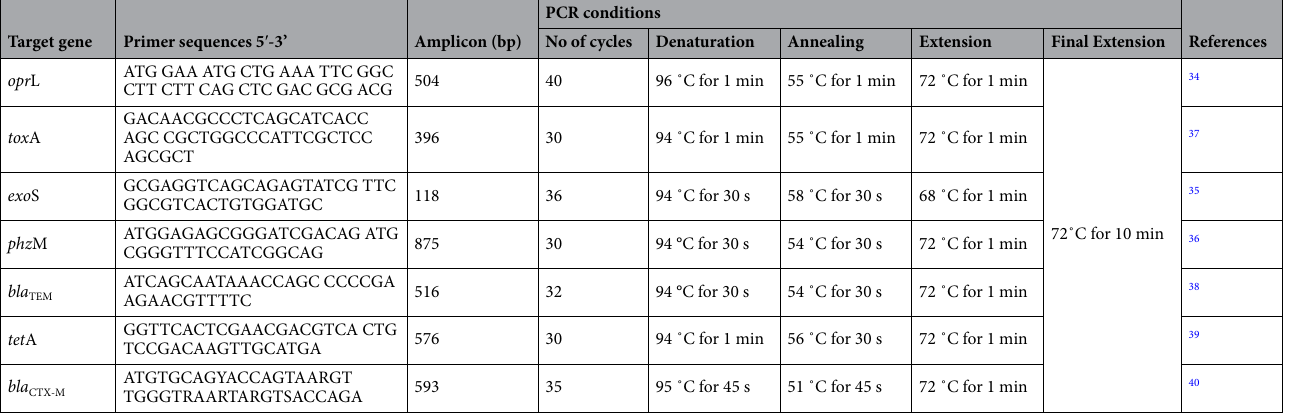
Table 1. List of oligonucleotide sequences and their PCR conditions used in the current